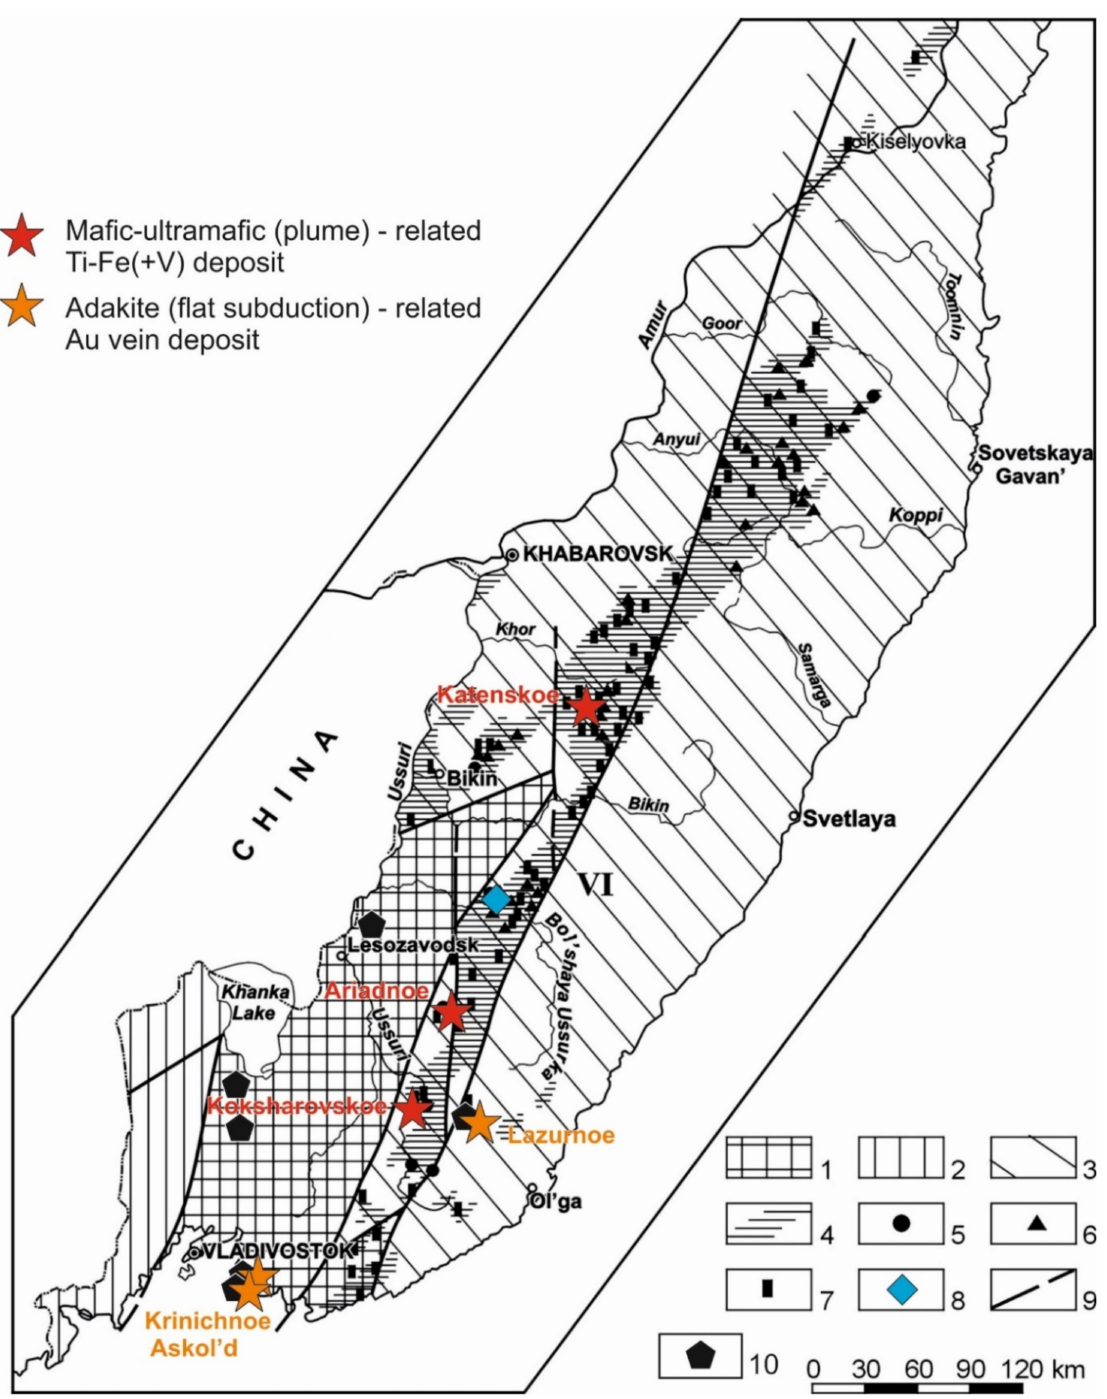
Figure 5. Location of the Jurassic–Early Cretaceous meymechite-picrite and Early Cretaceous adakite complexes and related mineral deposits in the Russian Far East (after [10,26] with additions from